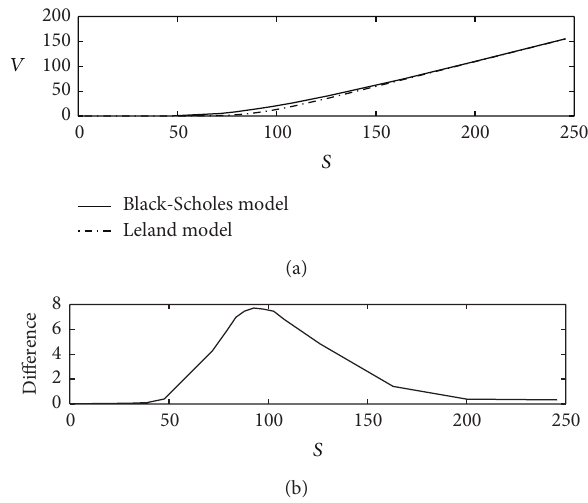
Figure 3: Difference of call option price between Black-Scholes model and Leland